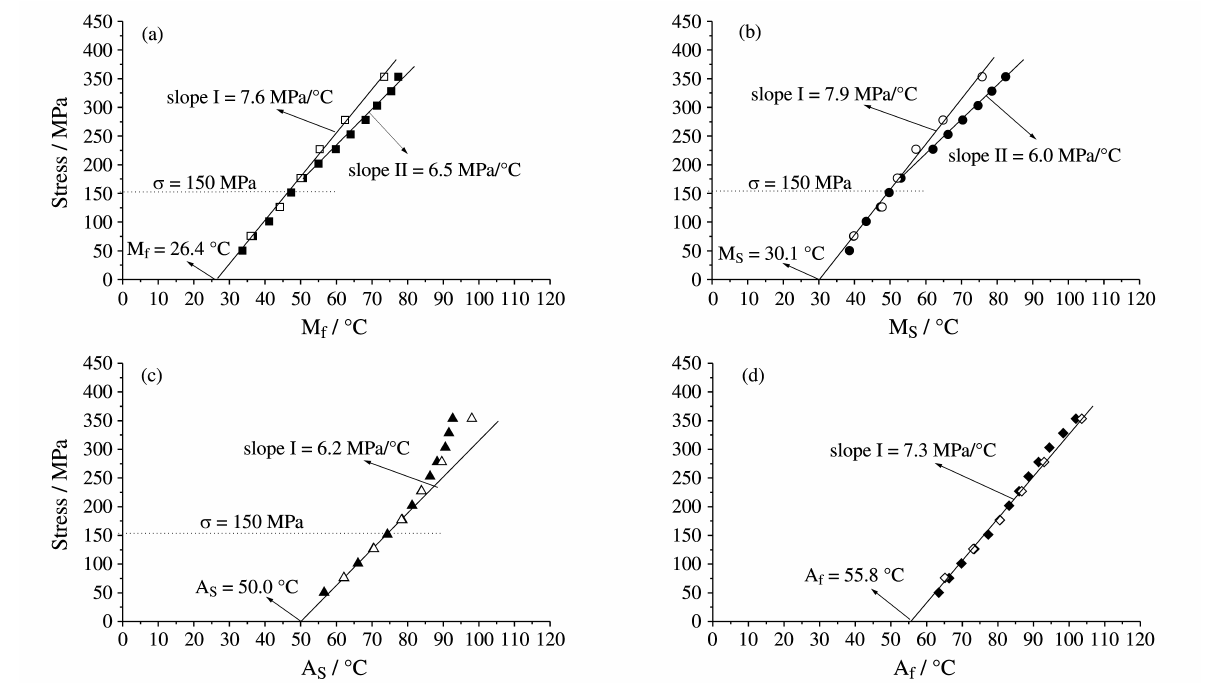
Figure 6. Transformation temperatures measured from the strain loops during tests I and II. (a) M f . (b) M S . (c) A S . (d) A f